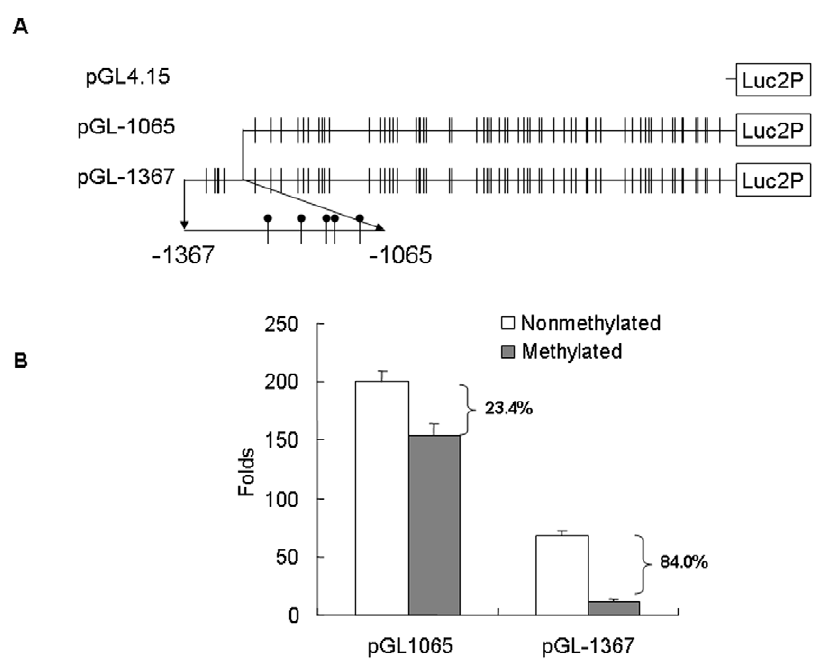
Figure 2. Methylation of the first 5 CpGs inhibited the transcriptional activity of Nrf2 promoter. ( A ) The construction of luciferase reporters is schematically presented. Nrf2 promoters with ( 2 1367–1) or without ( 2 1065–1) the extra sequence containing the first 5 CpGs were amplified from mouse genomic DNA and inserted into pGL 4.15 vector. The resulted reporters were designated as pGL-1367 and pGL-1065, respectively. ( B ) pGL-1367 or pGL-1065 reporters, either methylated by CpG methyltransferase or not, were co-transfected with pGL 4.75 vector which contains a Renilla reniformis luciferase gene driven by CMV promoter into TRAMP C1 cells, and the luciferase activities were measured after 24 hrs. The transcriptional activities of each constructs were calculated by normalizing the firefly luciferase activities with corresponding Renilla luciferase activities, and are represented as folds of induction compared with the activity of empty pGL 4.15 vector. The values are mean 6 SD of four separate